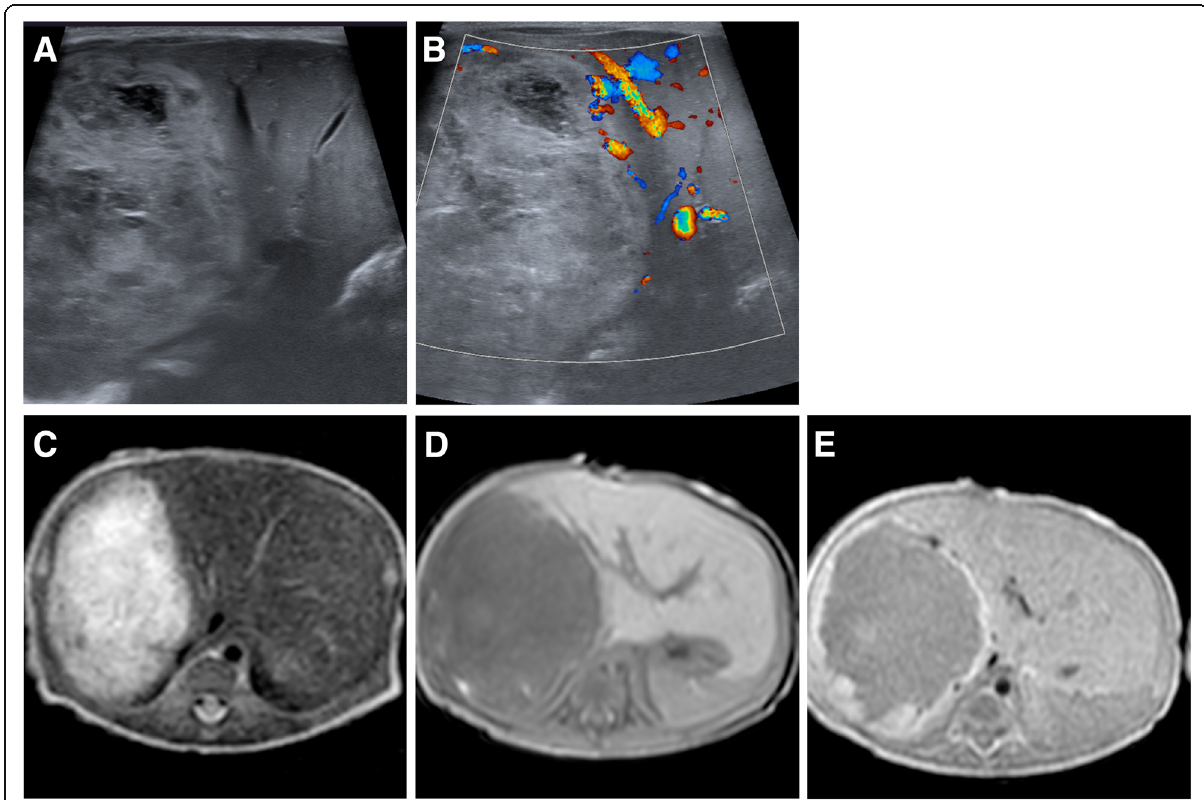
Fig. 3 Rapid-involuting hemangioma (RICH) in a newborn. Ultrasound depicted a heterogeneous, fully developed mass invading large parts of the right liver lobe ( a ) with no flow-signal on Doppler ultrasound ( b ). MRI showed a rather homogeneous mass ( c , d ) with uniform enhancement after gadolinium administration ( e ). The tumor did not increase in size after birth and at the age of 8 months had decreases from 3.7 cm in maximum diameter at birth to 2.0 cm without the need for surgical or interventional